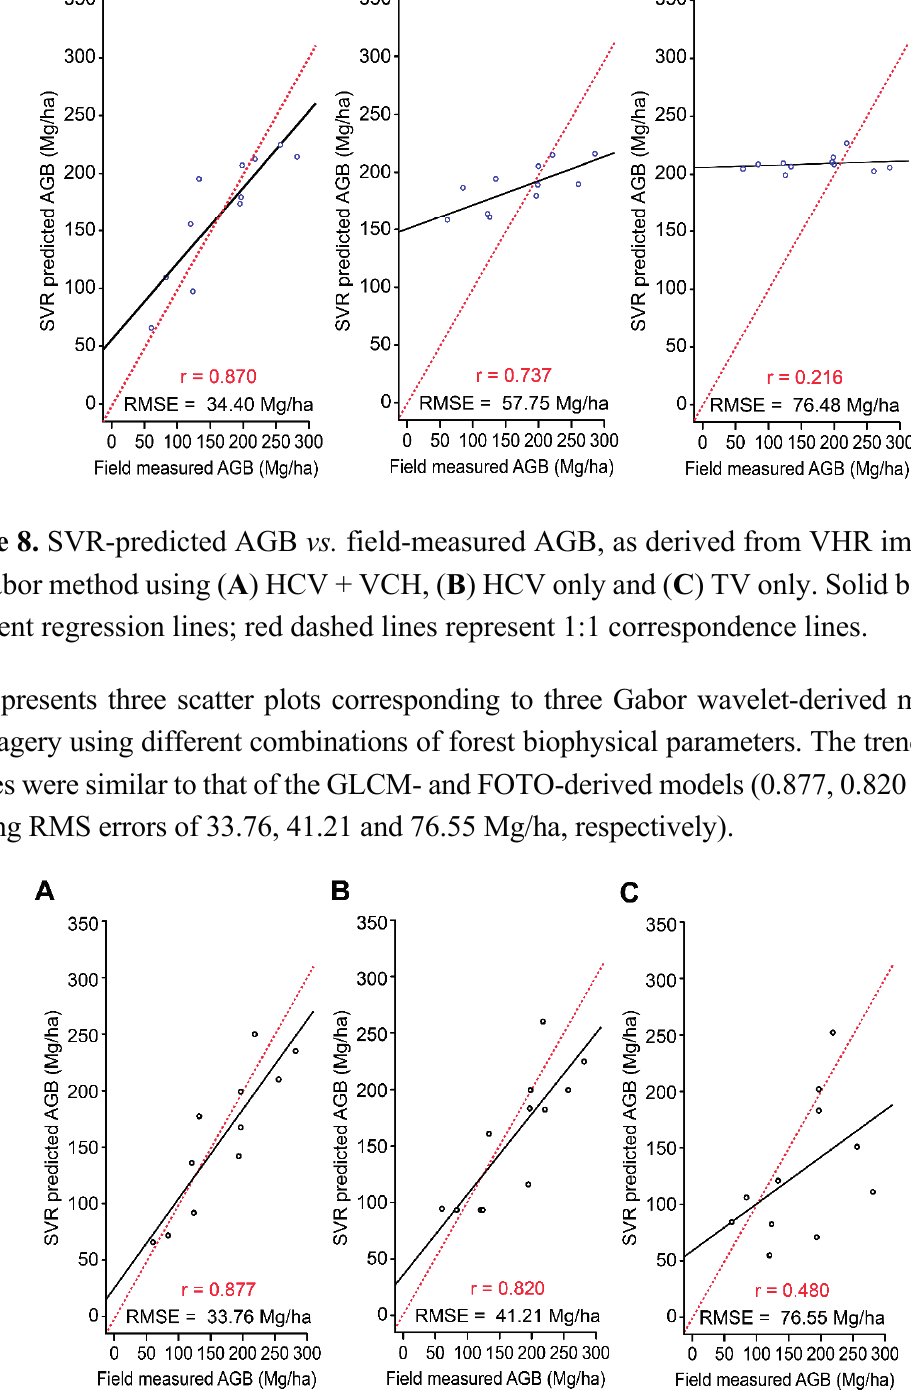
Figure 9. SVR-predicted AGB vs. field-measured AGB, as derived from Google Earth™ imagery via the Gabor method using ( A ) HCV + VCH, and ( B ) HCV only and ( C ) TV only. Solid black lines represent regression lines; red dashed lines represent 1:1 correspondence